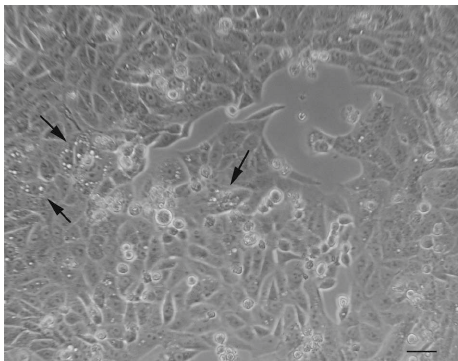
Figure 5. Optical microscopic observation of autophagic tumor cells after treatment with natural compound. As indicated by arrows, there are visible holes inside the cytoplasm. Scale bar: 20 µ m.